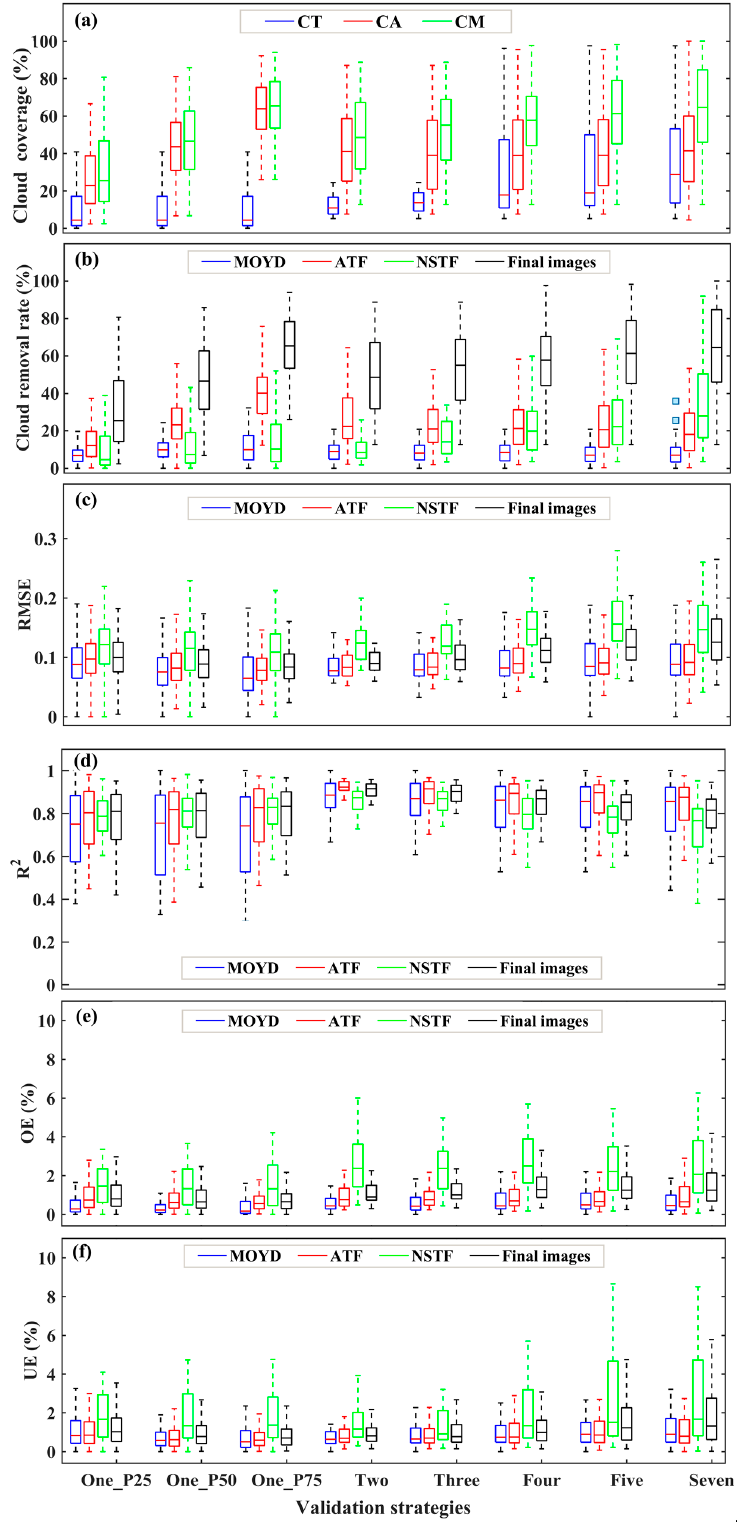
Figure 11. Performance evaluation results of validation based on “cloud assumption”. ( a ) Cloud coverage of selected “cloud-free” MODIS Terra SCF images (CT), additional cloud cover introduced by mask images (CA), and artificially cloud-filled images (CM). ( b – f ) Cloud removal efficiency, RMSE , R 2 , OE , and UE of MODY, ATF, NSTF, and final images.